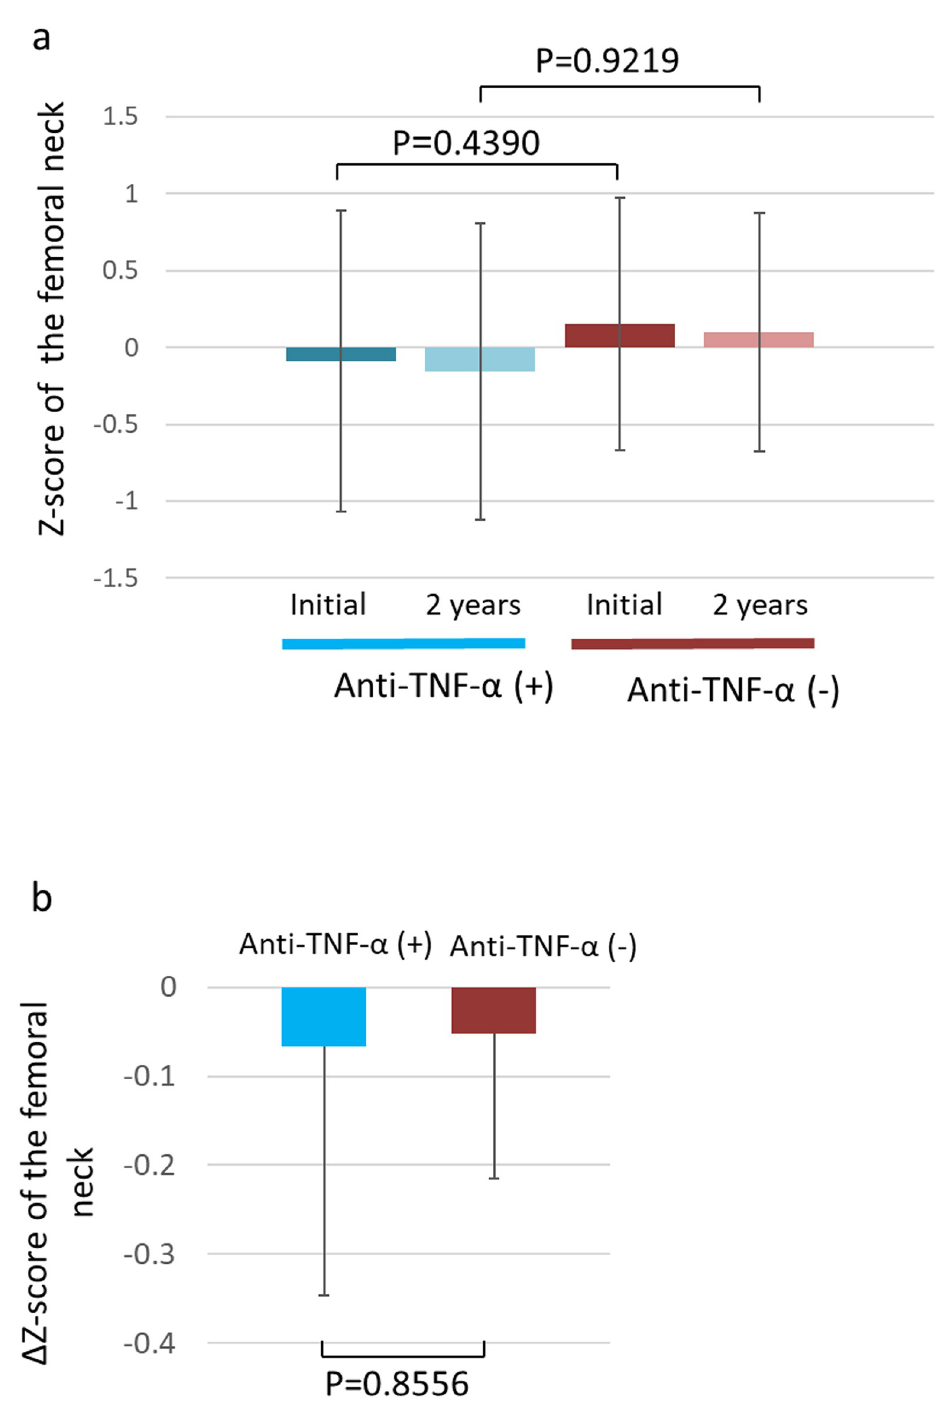
Fig 4. Change in the Z- and Δ Z-scores of the femoral neck. (a) Femoral neck Z-scores of the anti-TNF- α administration and non-administration groups at the first measurement and 2 years later. (b) Femoral neck Δ Z-scores of the anti-TNF- α administration and non-administration groups. TNF- α , tumor necrosis factor α .